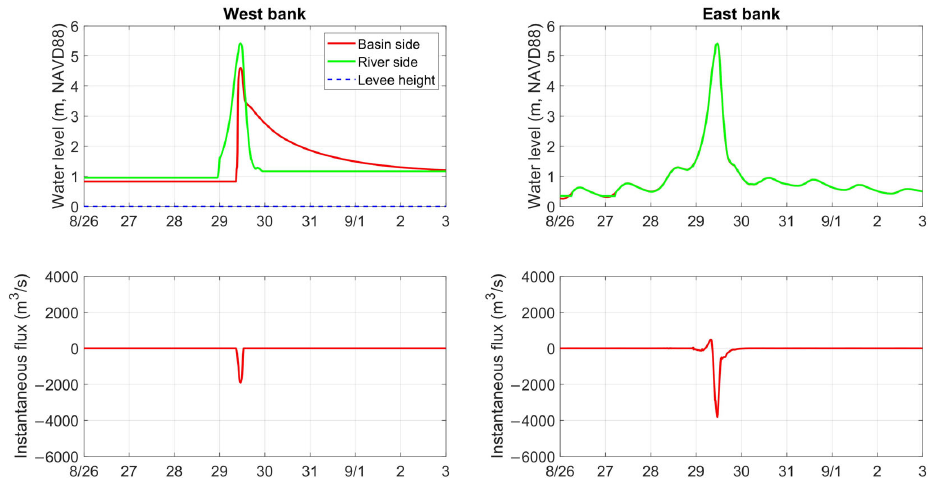
Figure 9. Time series of water level (m, NAVD88, top) and instantaneous flux (m 3 /s, bottom) for the west (left) and east (right) banks at the lower ‐ crossing location in the base case during Isaac (2012). The direction of positive flux is from west to east.